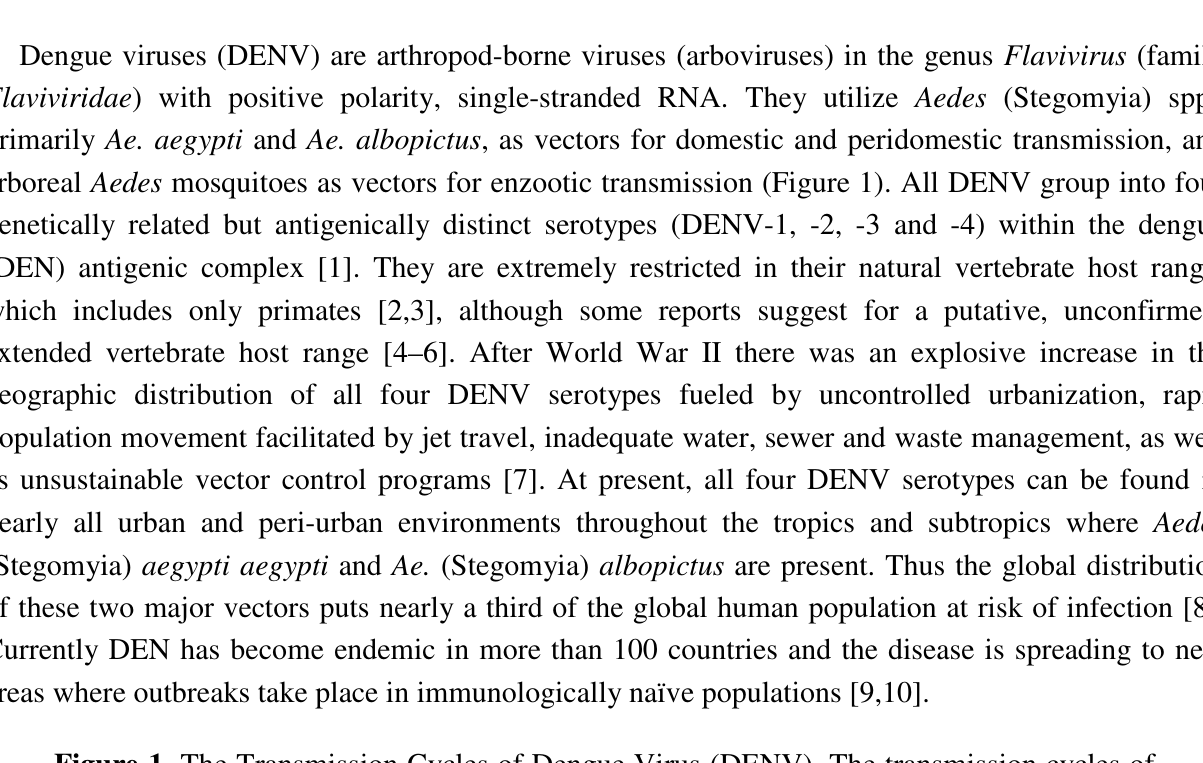
Figure 1. The Transmission Cycles of Dengue Virus (DENV). The transmission cycles of DENV, depicting the sylvatic origins and the ‘zone of emergence’ where sylvatic cycles contact human populations in rural areas in West Africa and Southeast Asia. Image courtesy of Shannan Rossi, Department of Pathology,